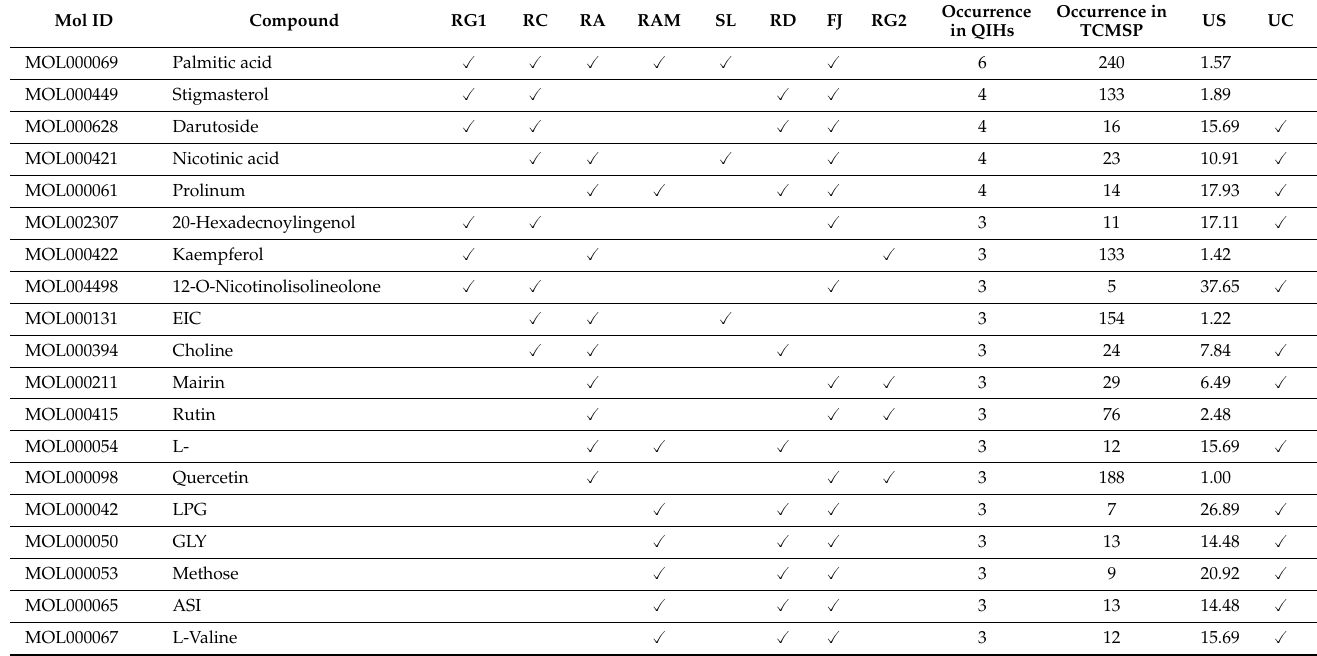
Table 3. Common and unique compounds of eight Qi-invigorating herbs.